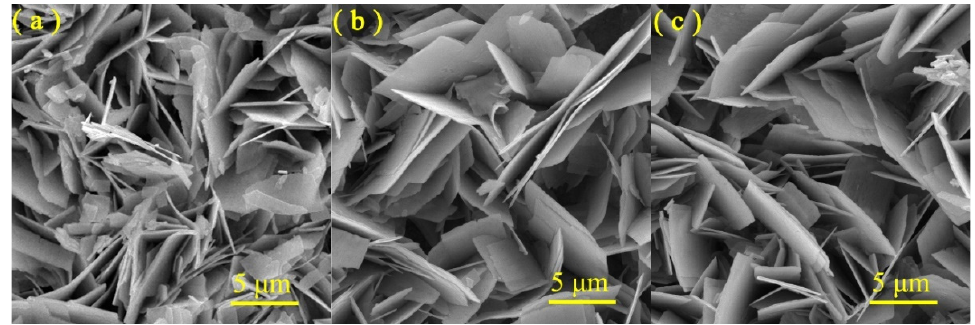
Figure 3. SEM images of WO 3 ( a ), Cu 2 O/WO 3 ( b ) and Cu/Cu 2 O/WO 3 ( c ) samples. Micro-structures of the obtained samples were investigated by TEM observation. Fig- ure 4 revealed that the typical nanoflake-like morphology was observed with a sharp edge and clean boundary. In Figure 4a, the WO 3 nanoflake had a porous surface morphology. The fringe spacings of 0.634 and 0.366 nm were discovered (inset of Figure 4a), which were consistent with the (1 0 0) and (0 0 2) lattice planes of hexagonal WO 3 , respectively.